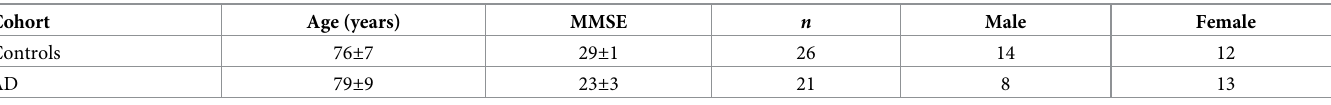
Table 1. Participant demographics. The columns showing age and mini-mental state examination (MMSE) scores show means and standard errors over participants.